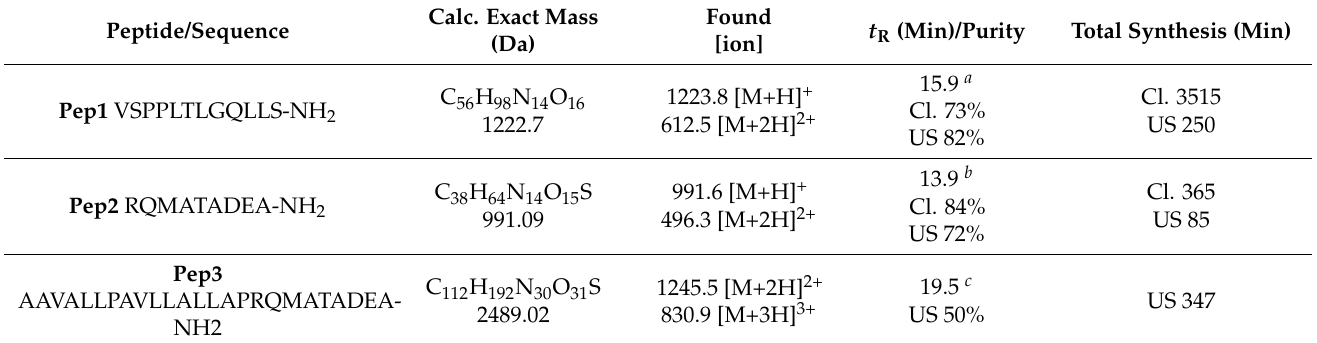
Table 1. Analytical characterization and complete synthesis times for Pep1 , Pep2 and Pep3 . Calc. Exact Peptide/Sequence